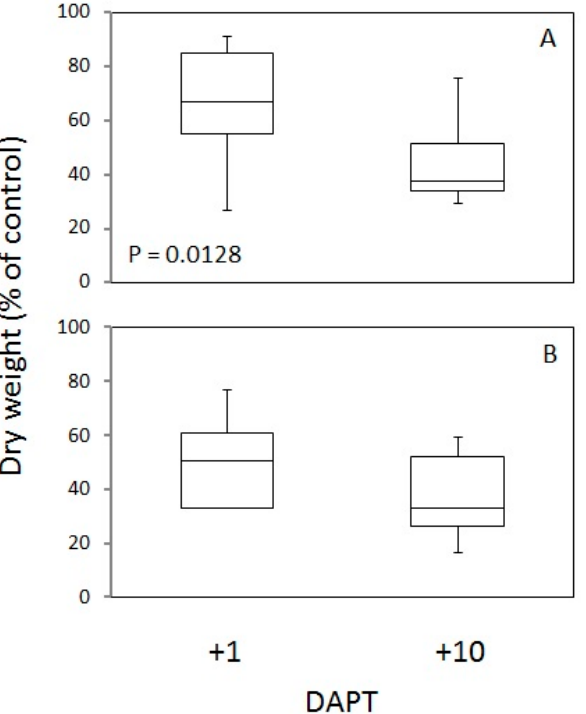
Figure 3. The impact of third treatment timing (1 or 10 days after previous treatment (DAPT)) on the above-ground dry weight ( A ) and root dry weight ( B ) (% of control) of Cyperus rotundus . p -values were determined by Student's t-test. Values are mean ± SE ( n = 7).